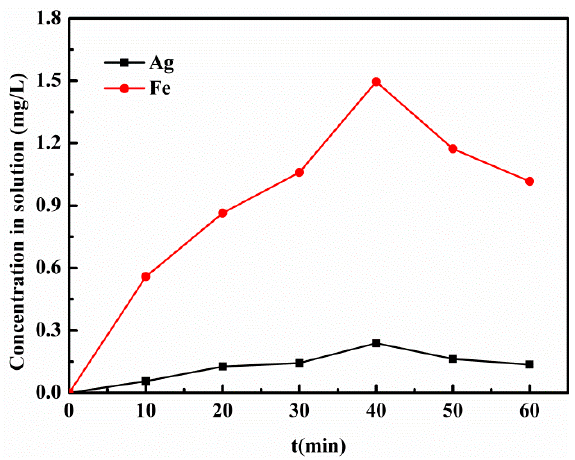
Figure 12. The cycling runs of MB degradation in the photo ‐ Fenton system catalyzed with Ag/AgCl/MIL ‐ 101(Fe).